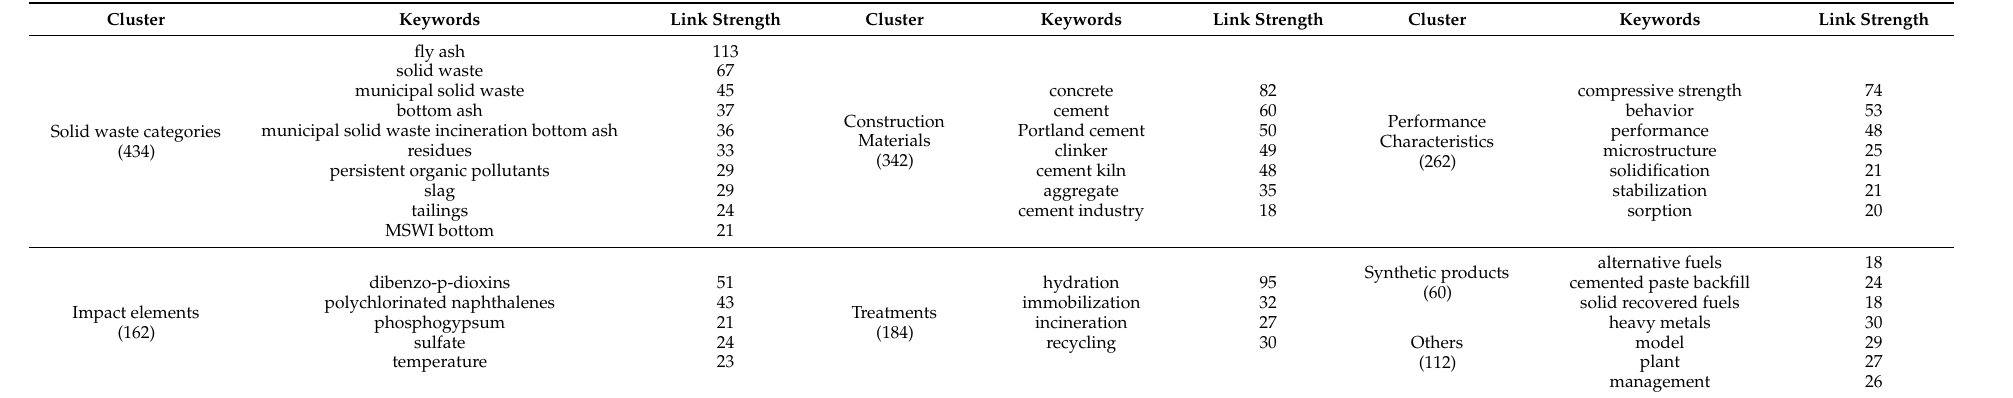
Table 4. The keyword statistics of seven clusters and their link strength.